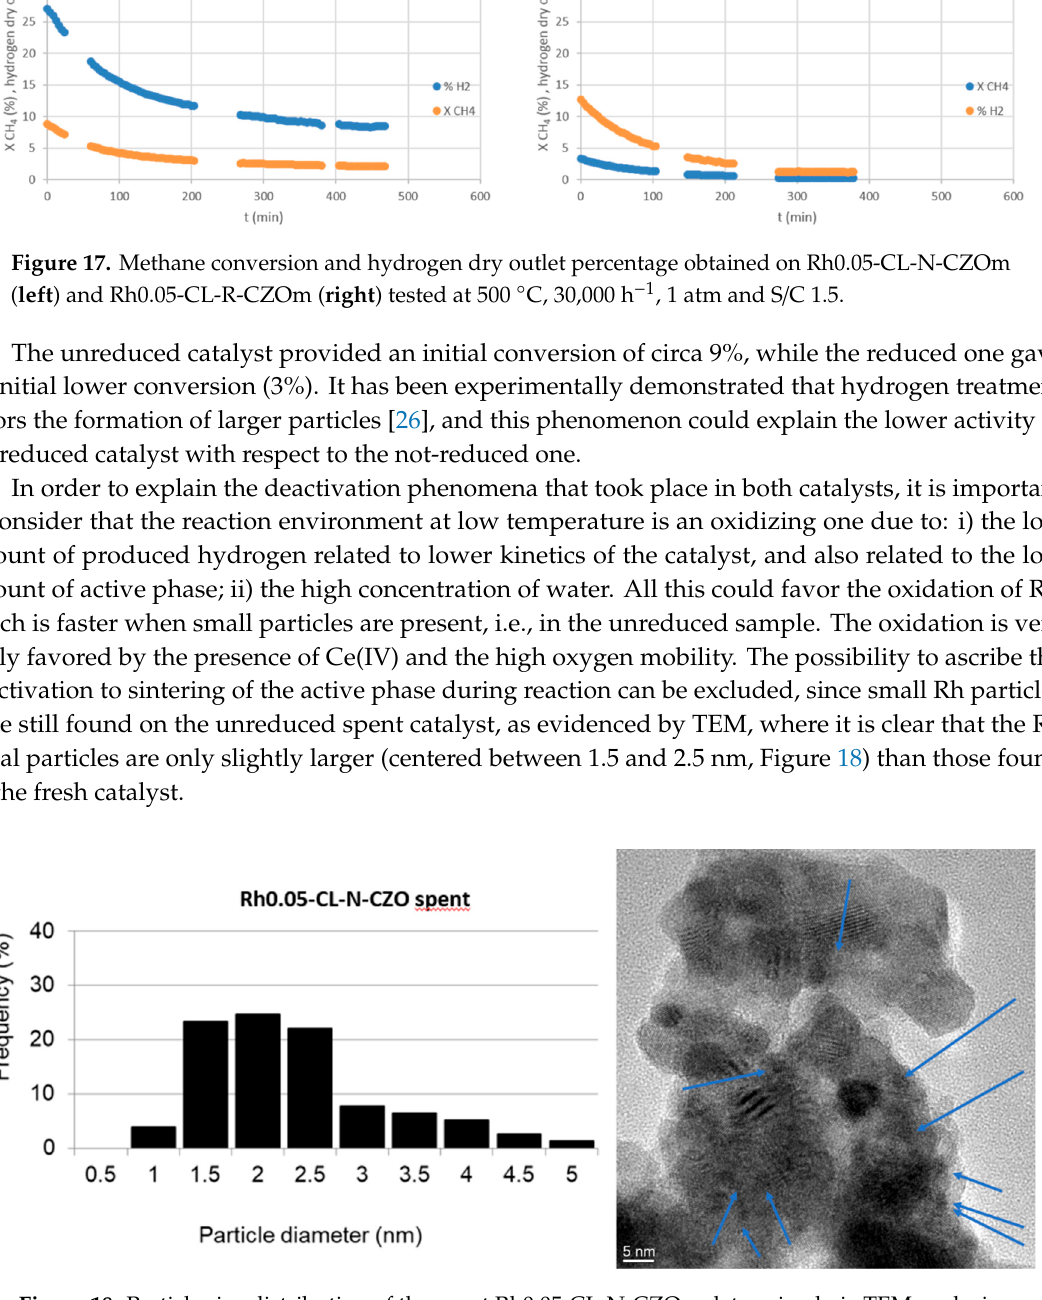
The catalytic performances of the Rh cluster deposited on ZOm, both not reduced and reduced